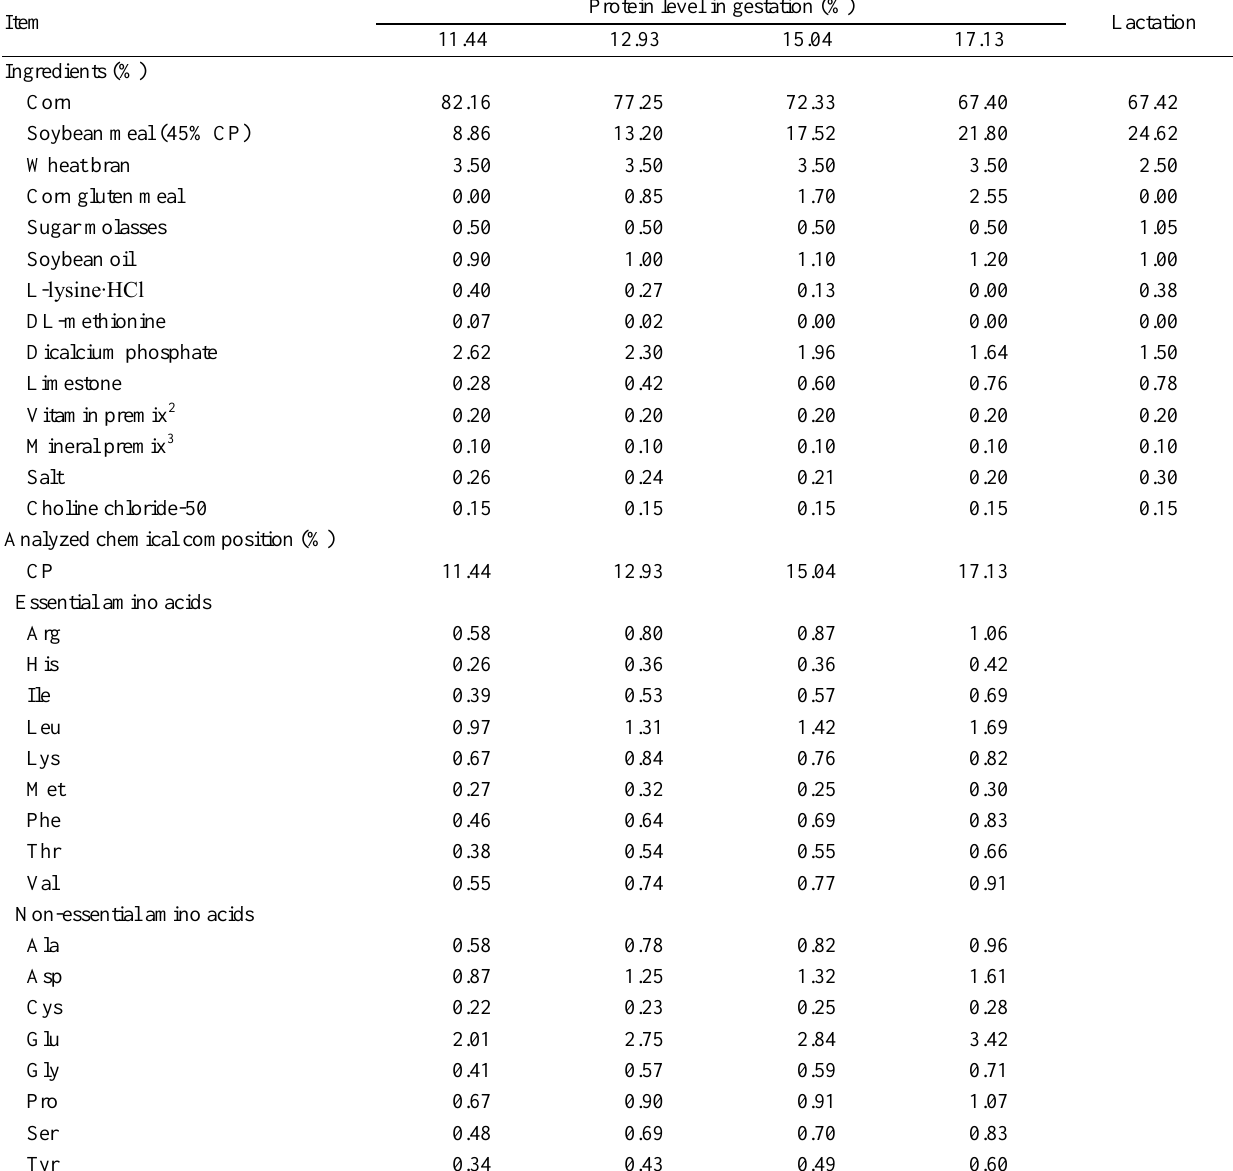
Table 1. The formula and chemical composition of experimental diets in gestation and lactation (as-fed basis) 1